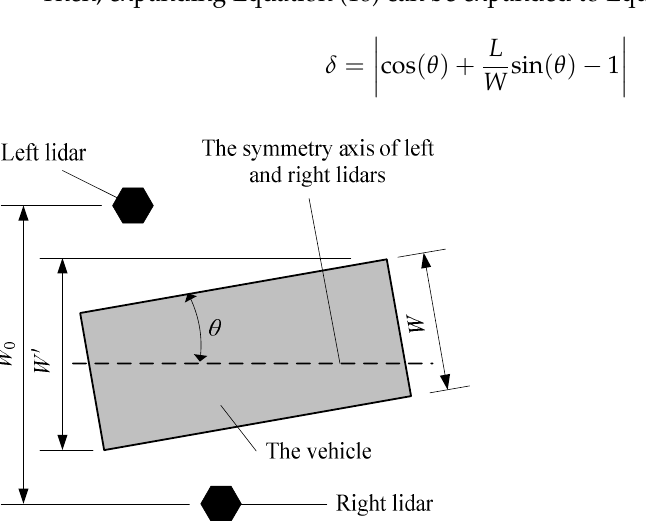
Figure 12. Influence of vehicle moving deviation error on vehicle width measurement.